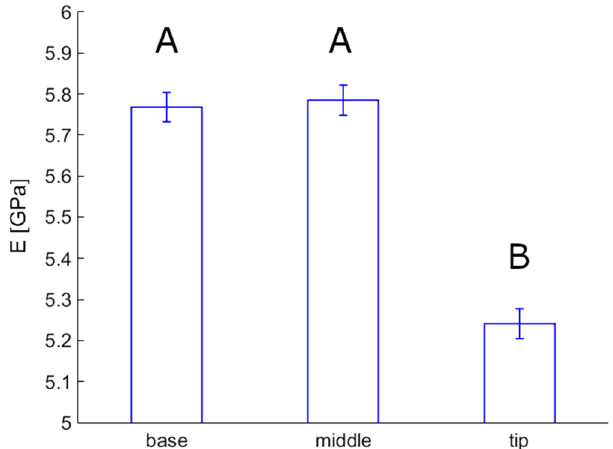
Figure 1. Effect of locations on Young’s modulus values of feathers. Mean values (bars) and standard error (whiskers) are presented for base, middle, and tip regions of the feather shaft. 32 feathers from 32 animals were used for the comparison. The number of individual measurements in the above-mentioned regions was 572, 537, and 546,